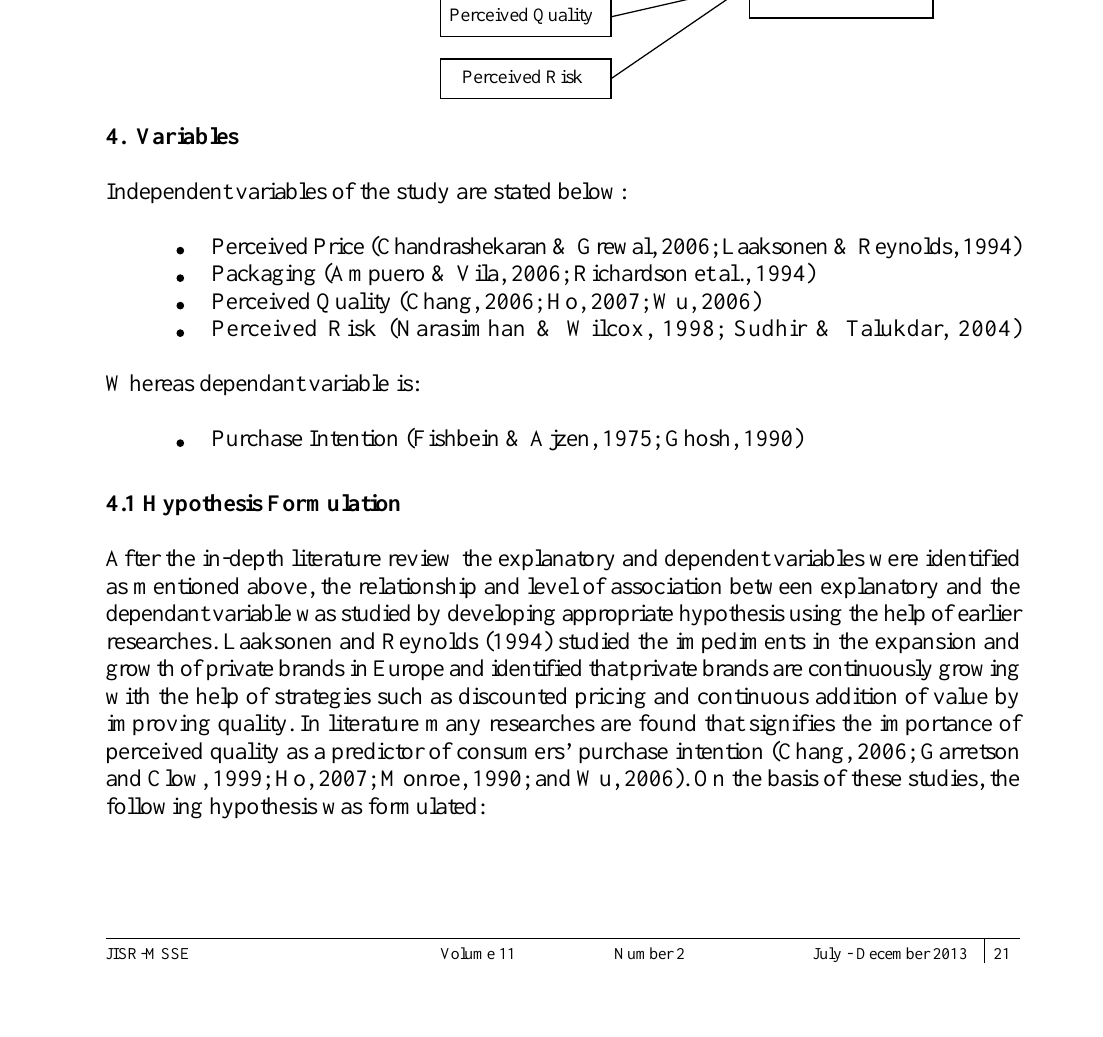
Purchase Intention